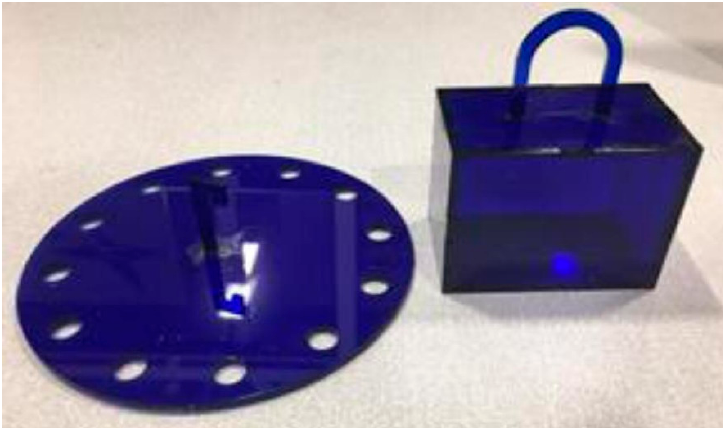
Figure 11. Hook and box with handle for pick-and-place tasks. The box dimensions are 10 cm × 5 cm × 5 cm and was produced using laser-cutting technology.